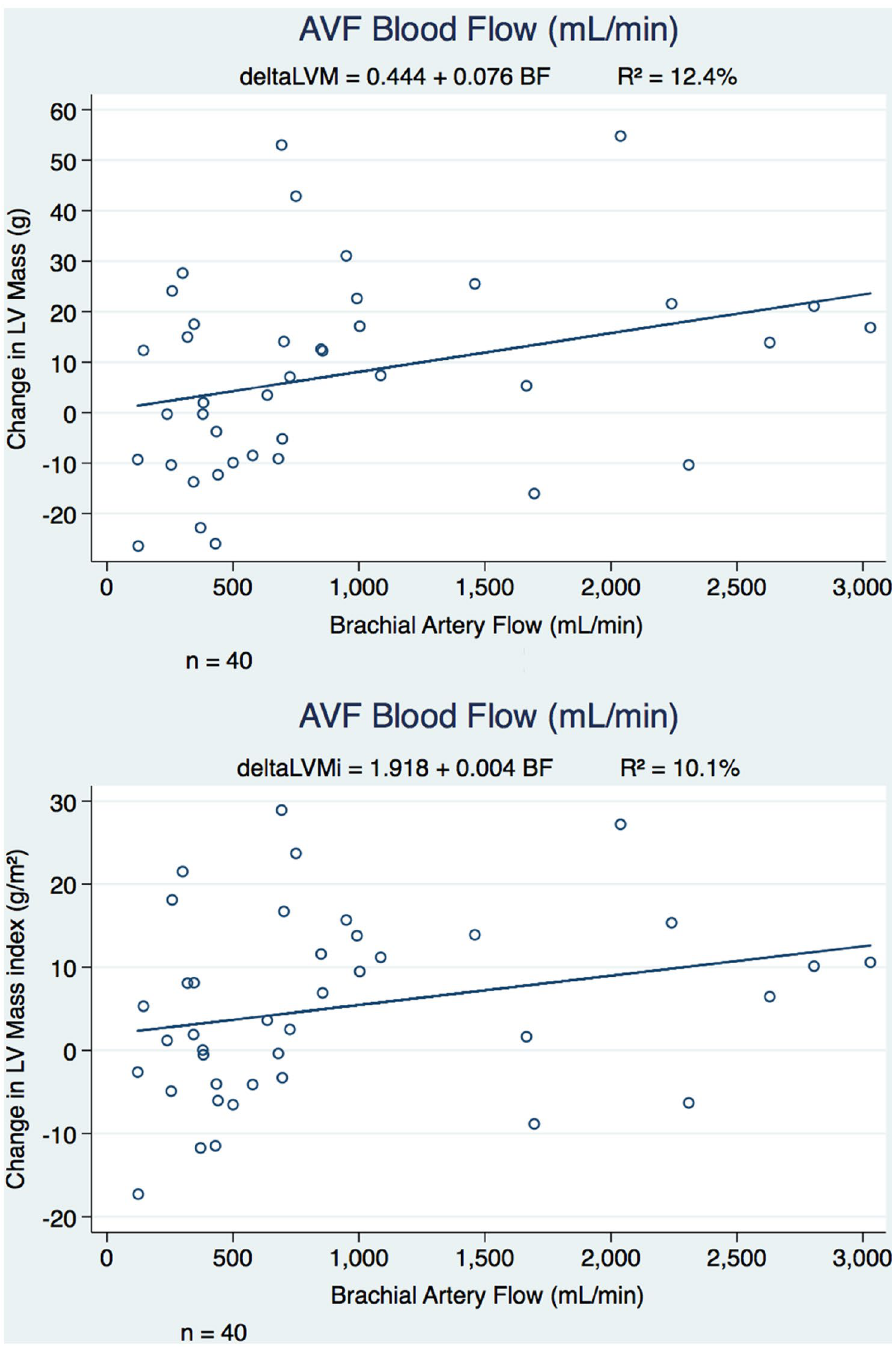
Figure 3. Effect of arteriovenous fistula (AVF) creation based on AVF blood flow. Linear regression analysis looking at change in LV mass (above) and LV mass index (below) in study participants with AVF